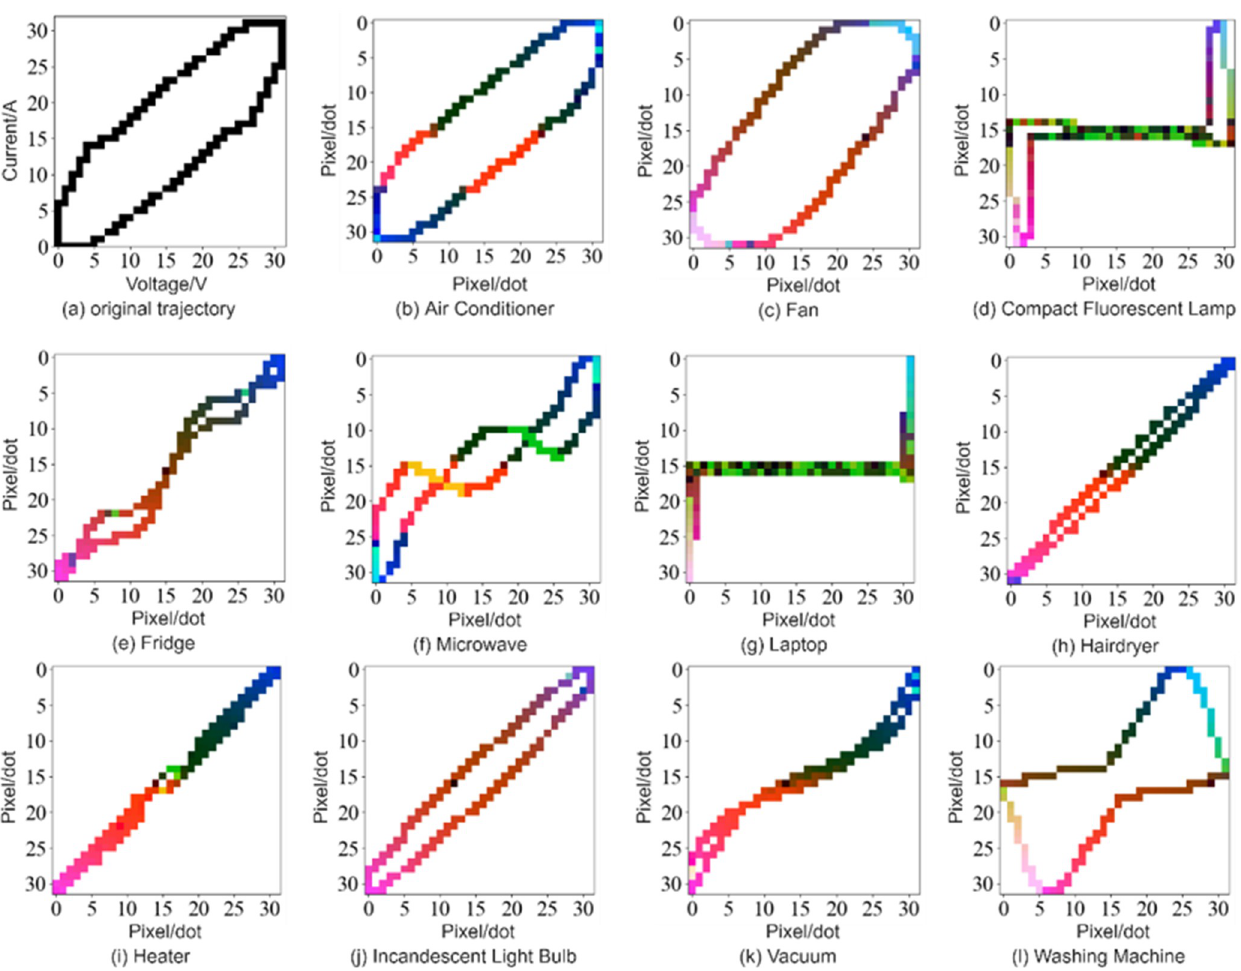
Fig 4. Color V-I trajectory images of 11 types of appliance loads in the PLAID dataset ( N = 32).